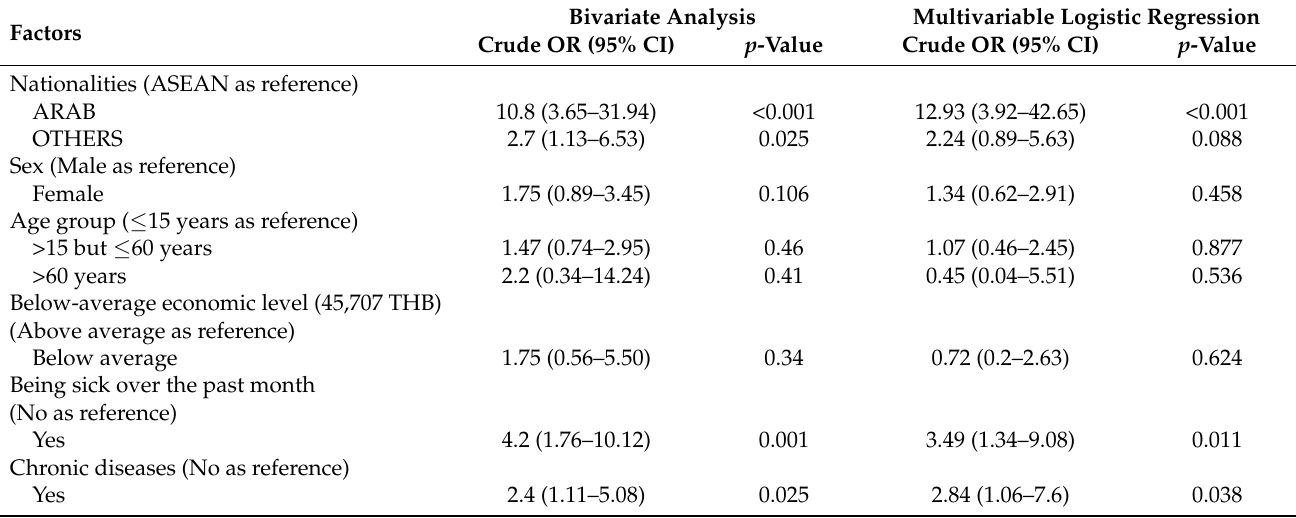
Table 4. Bivariate analysis and multivariate logistic regression for unmet need of in-patient (IP) care. Bivariate Analysis Multivariable Logistic Regression Factors Crude OR (95% CI) p -Value Crude OR (95% CI) p -Value 10.8